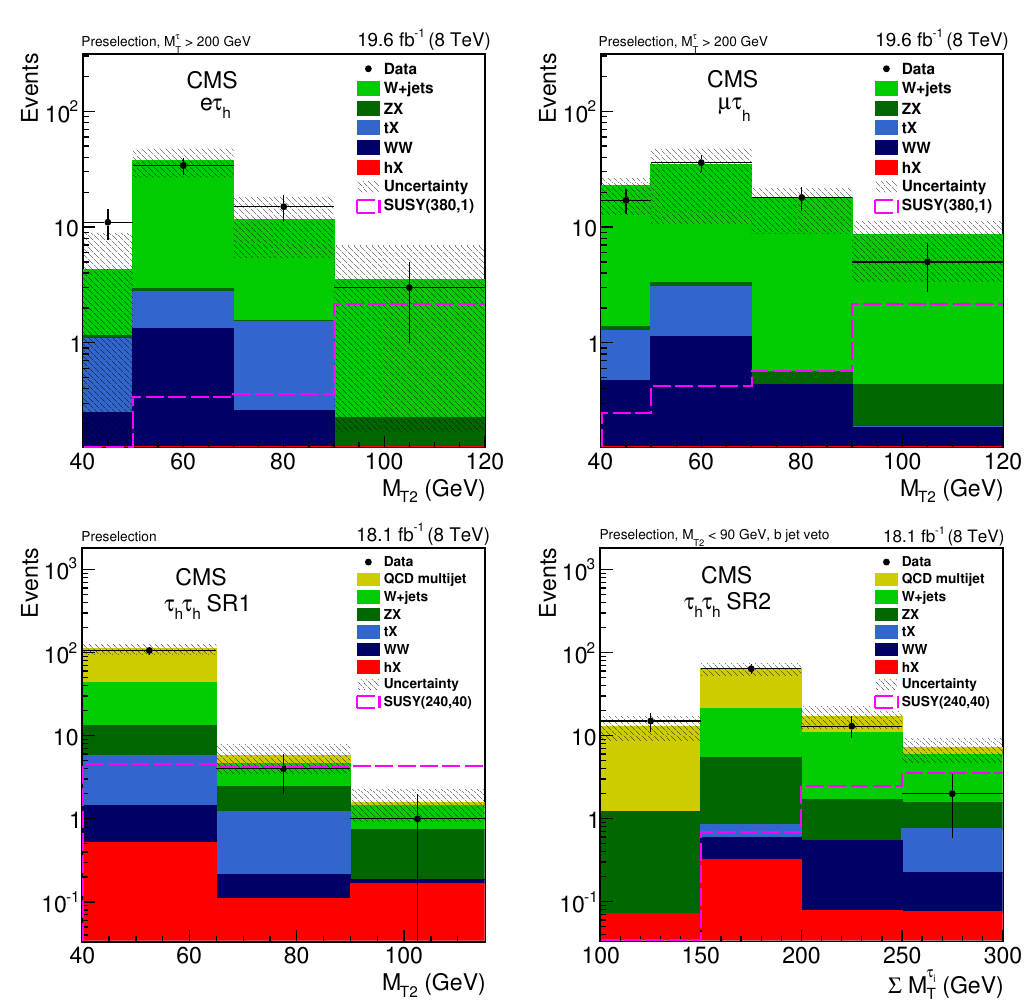
Figure 4 . The data yield is compared with the SM expectation. In di(cid:11)erent signal regions, when a background estimate from data is available, it is used instead of simulation, as described in the text. The signal distribution for a high (cid:1) m scenario with m compared with the yields of ‘(cid:28) h channels while a scenario with lower (cid:1) m ( m m = 40 GeV) is chosen for the comparison in (cid:28) h (cid:28) h channels. The higher values of M T2 or (cid:6) M (cid:28) i e (cid:31) 0 1 are included in the last bins. The shown uncertainties include the quadratic sum of the statistical and systematic